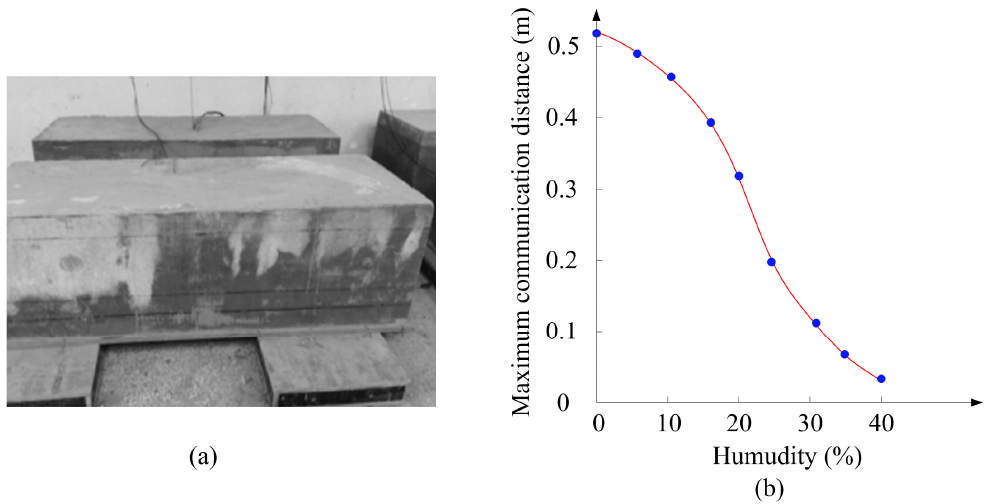
Figure 13. Maximum communication distance at 915 MHz: ( a ) test environment; ( b ) test results.